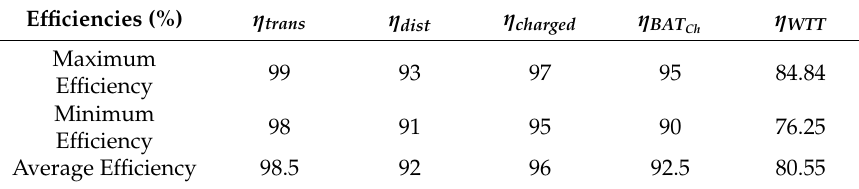
Table 9. Global efficiency of the components of the system when charged [55,56].